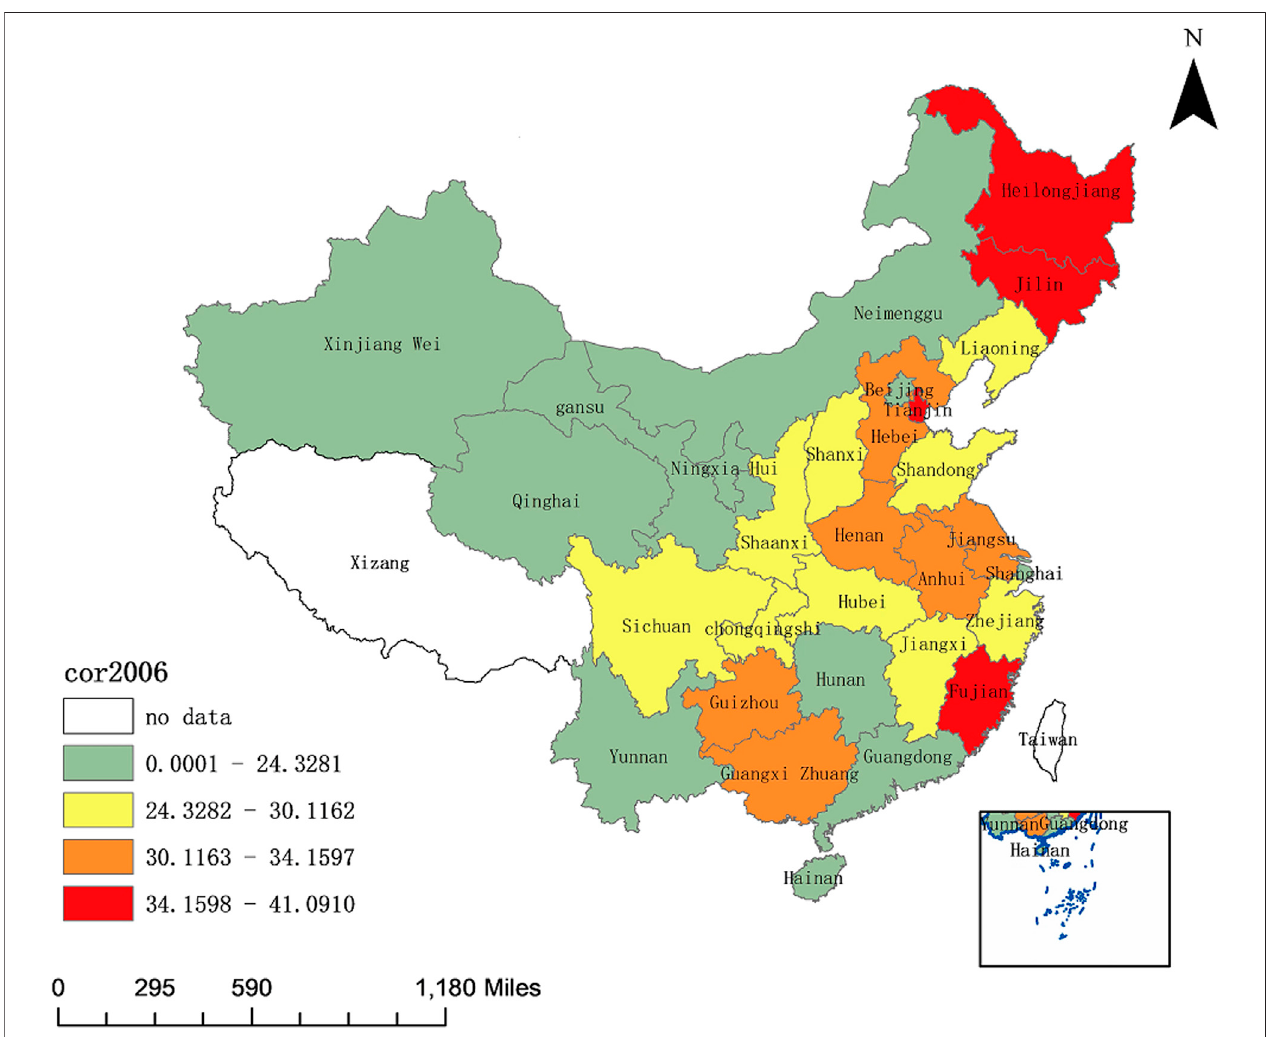
FIGURE 1 | Corruption levels in Chinese provinces in